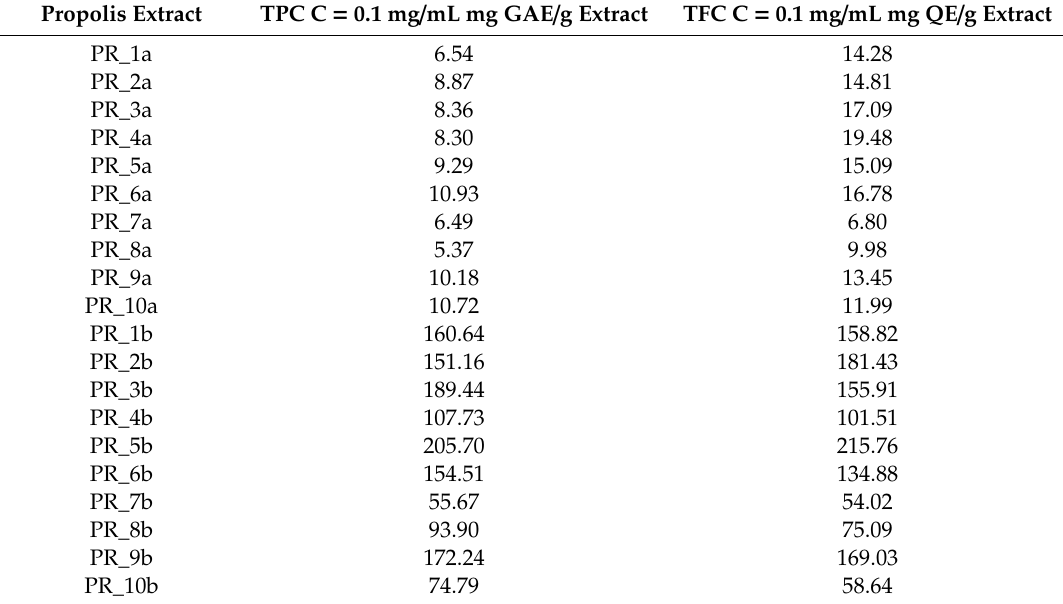
Table 3. Total phenolic content (TPC) and total flavonoid content (TFC) of the ten extracts of